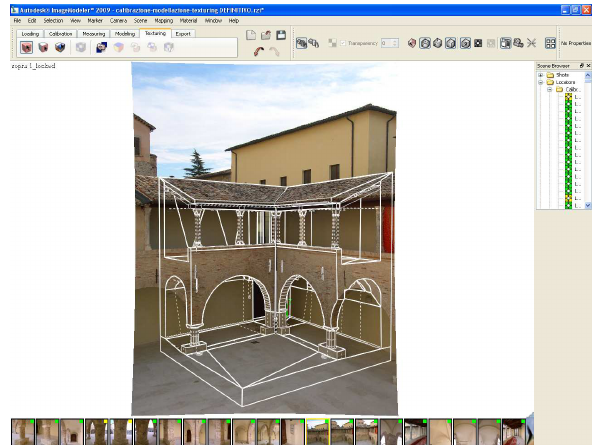
Figure 11. Cloister of San Tommaso church: wireframe model